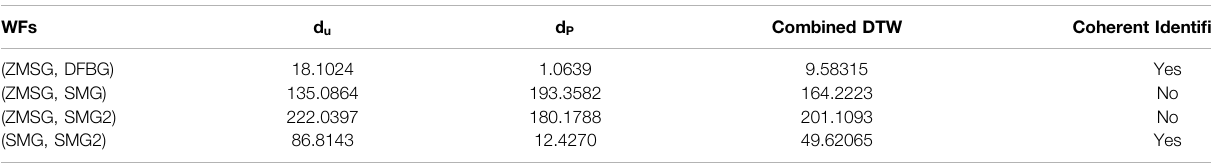
TABLE 2 | Results of combined DTW distance in Group 4.